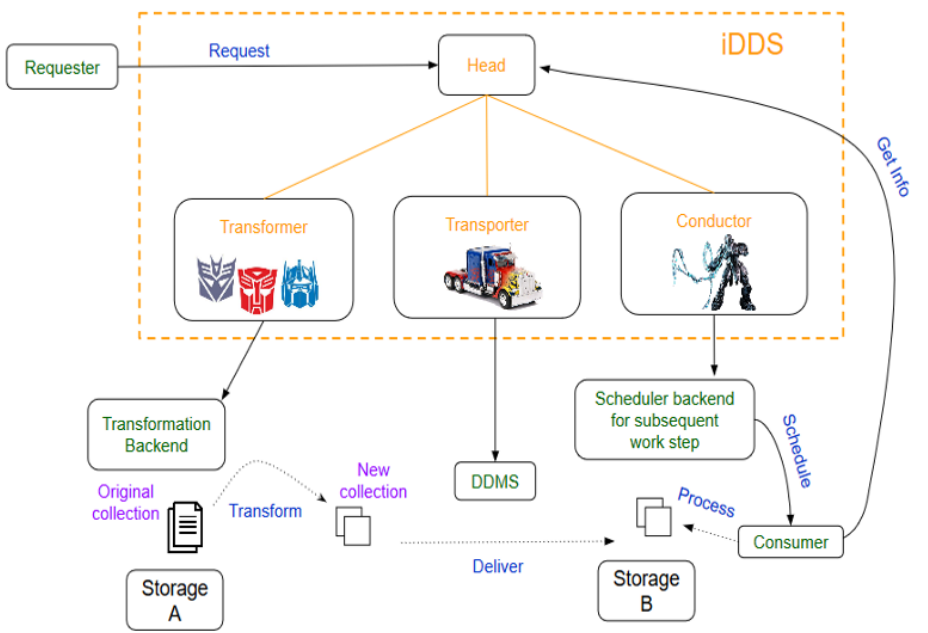
Fig. 2. A schematic view of the Intelligent Data Delivery